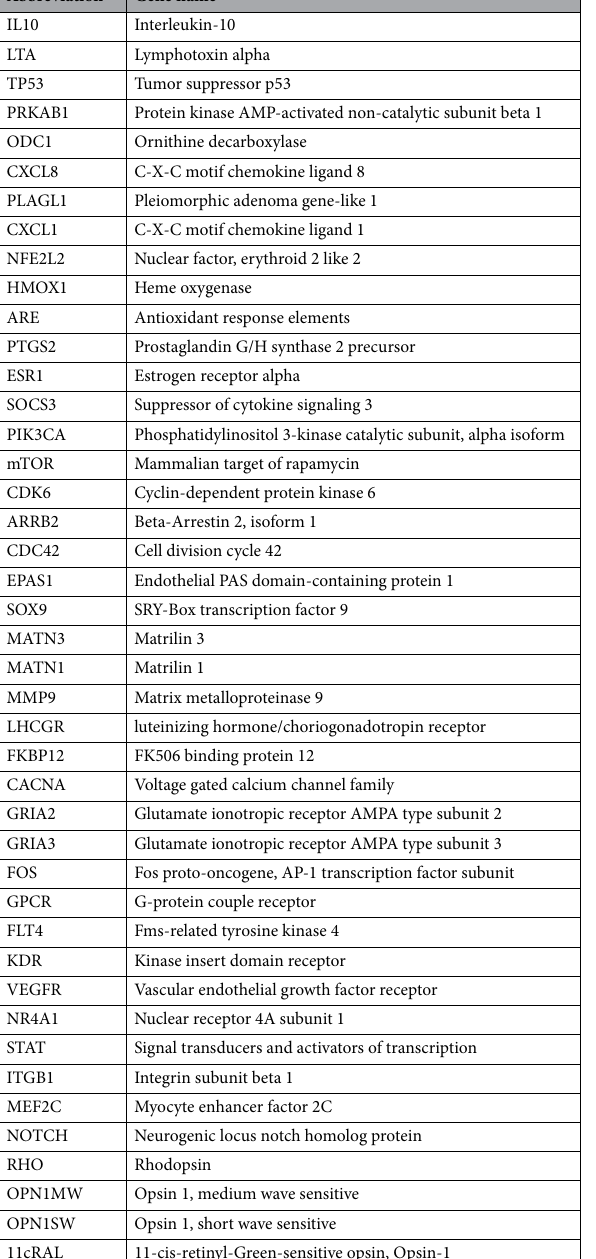
Table 3. Gene names and their